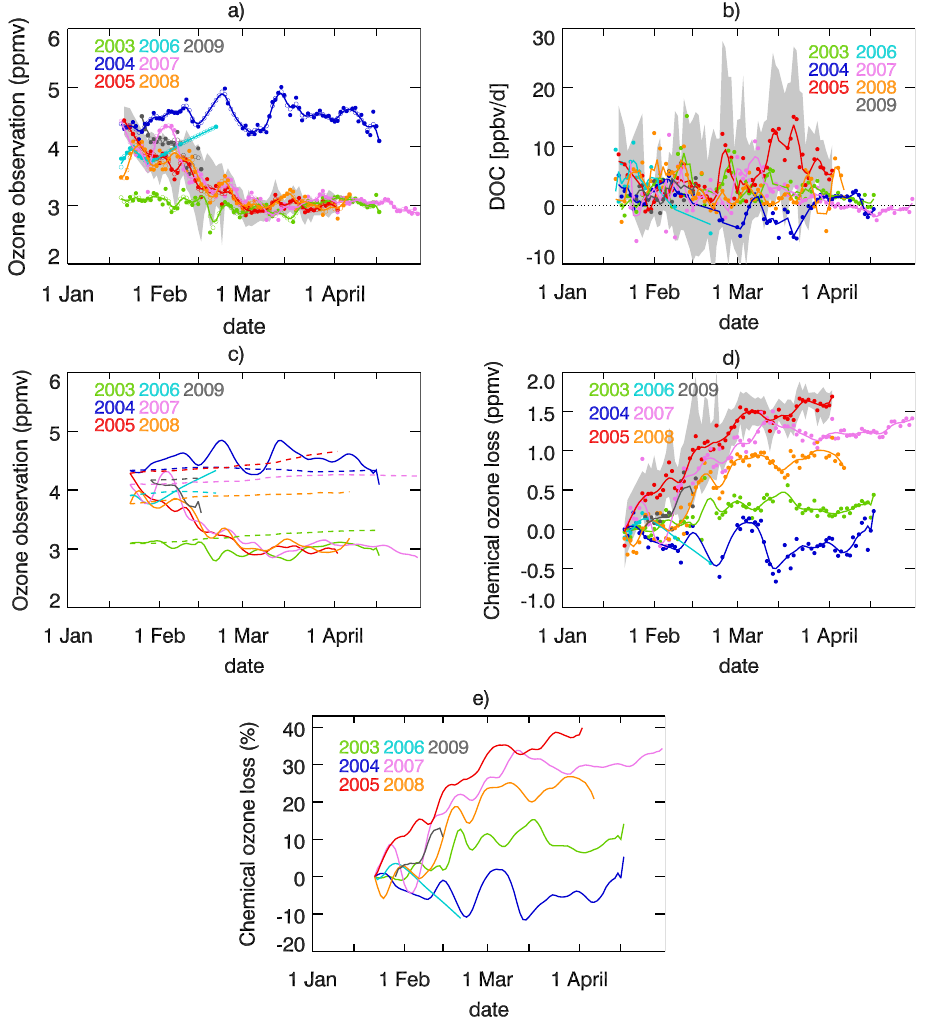
Fig. 4. Chemical ozone loss results for the Arctic polar vortices 2002/2003 to 2008/2009 at the 475K isentropic level and the periods listed in Table 1. (a) Observed vortex average ozone mixing ratio time series. The grey-shading indicates the standard deviations of the individual ozone measurements inside the vortex about the daily mean (for 2005 only, for reasons of clarity). Days with missing data and days where the SCIAMACHY instrument did not sample the vortex are filled using a spline interpolation. The solid and open circles show the original and interpolated data, respectively. (b) Daily ozone mixing ratio change (DOC) due to diabatic descent determined with MIDRAD model simulations. The time series are shown for the time periods listed in Table 1. (c) Accumulated ozone mixing ratio from daily diabatic descent (dashed lines) and the observed ozone mixing ratio time series (solid lines). (d) Chemical ozone losses inppmv. (e) Chemical ozone loss in percent relative to the start days listed in Table 1. The grey-shading in panels (b) and (d) corresponds to the 1- σ uncertainty based on the standard deviation of the ozone mixing ratio about the daily mean (only exemplarily shown for 2005).